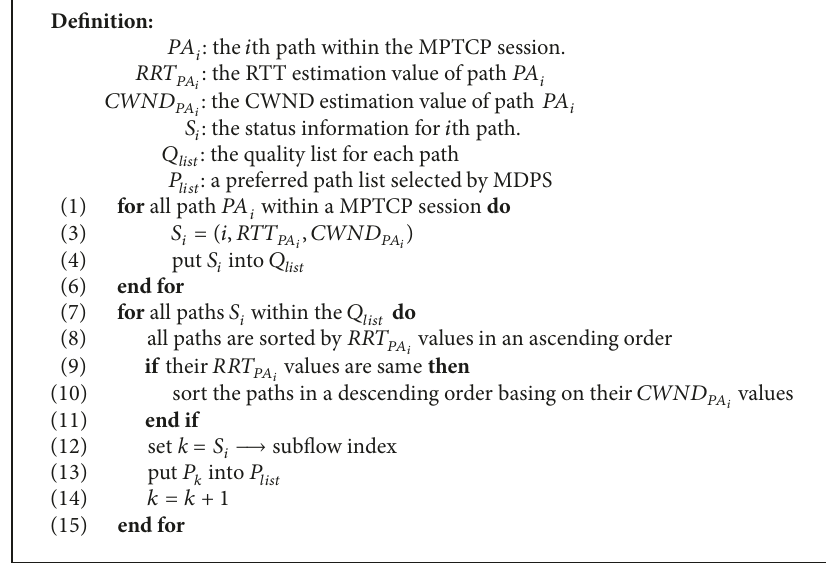
Algorithm 2: MDPS-based path information collection and sorting algorithm.